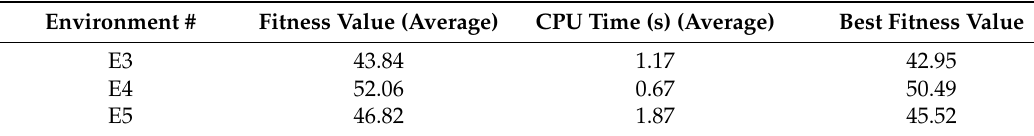
Table 5. Obtained results in Environments 3, 4, and 5.